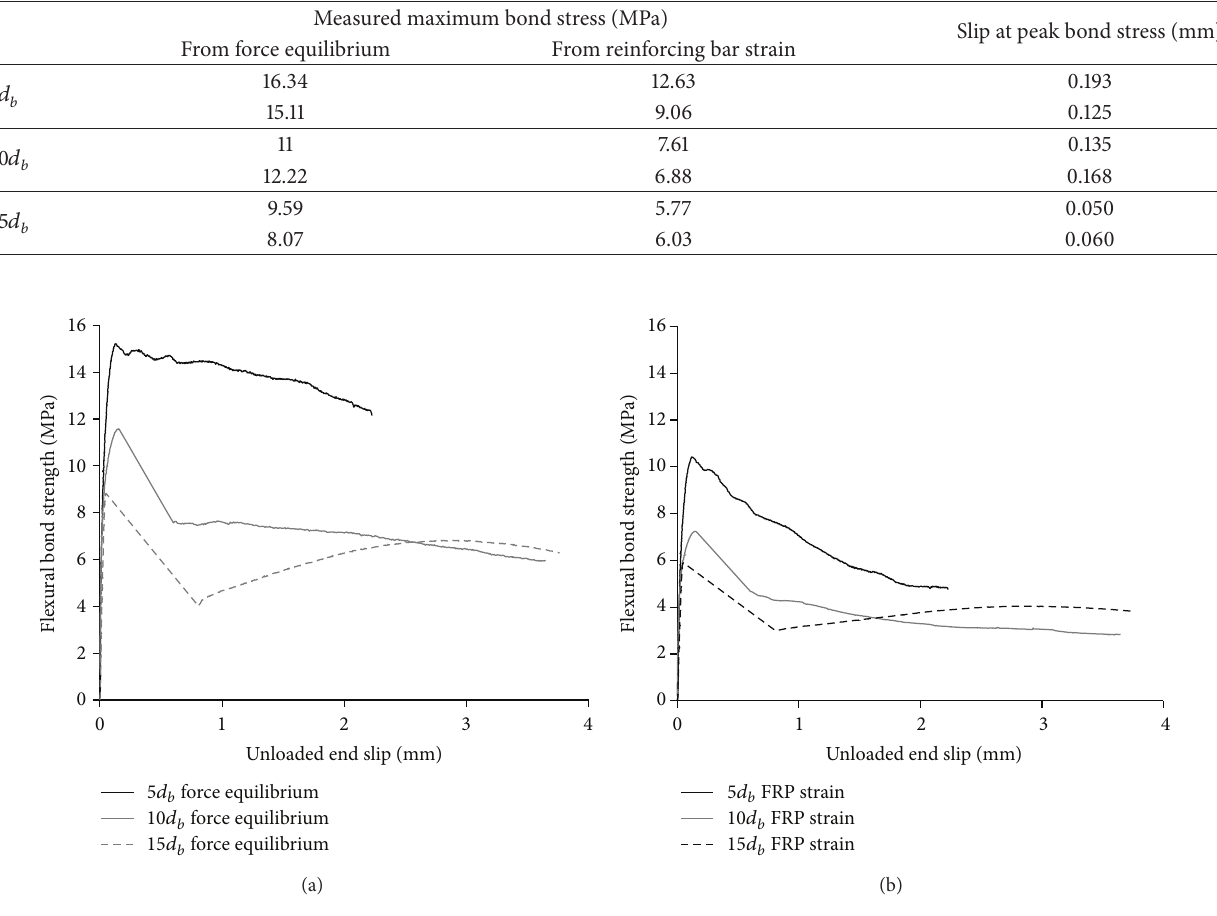
Figure 4: Relationship between flexural bond stress and slip under static loading